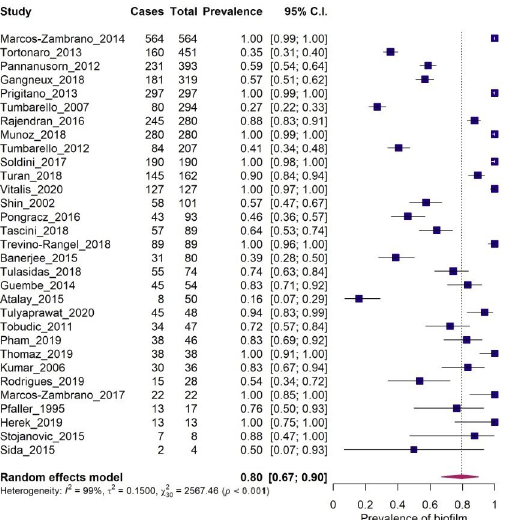
incidence of mortality among patients varied considerably among studies, reporting the values of attributable mortality between 6.9 and 70%. All the information extracted is available in the supplementary section. Analysis of the forest plot was then realized with data set, showing a pooled rate of biofilm formation of 80.0% (CI: 67–90), as shown in Fig 2. The heterogeneity indices obtained using